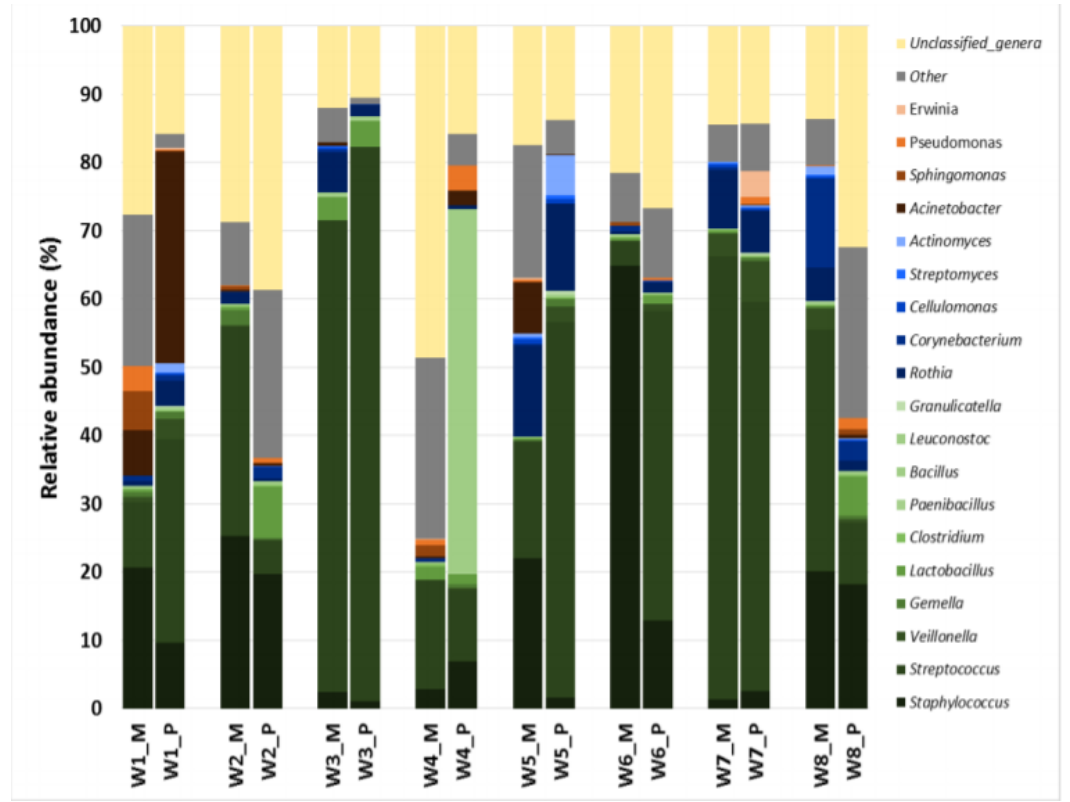
Figure 4. Comparison of individual profiles of the relative abundance of the most abundant bacterial genera in the milk samples provided by each woman ( n = 8; W_1 to W_8) using two collection methods: manual expression (M) or using a pumping device (P). manual expression (M) or using a pumping device